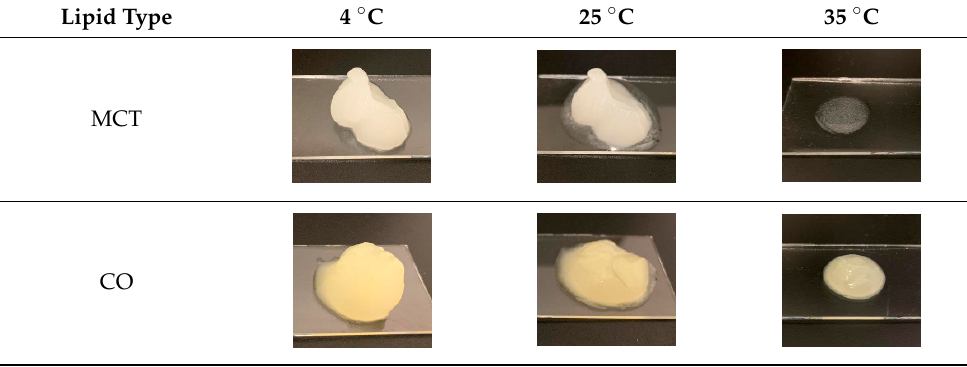
Table 1. Visual appearance at 4, 25 and 35 °C of the gelled lipid phases consisting on blends of medium chain triglyceride (MCT) or corn oil (CO), GS (1% w / w ) and PGPR.